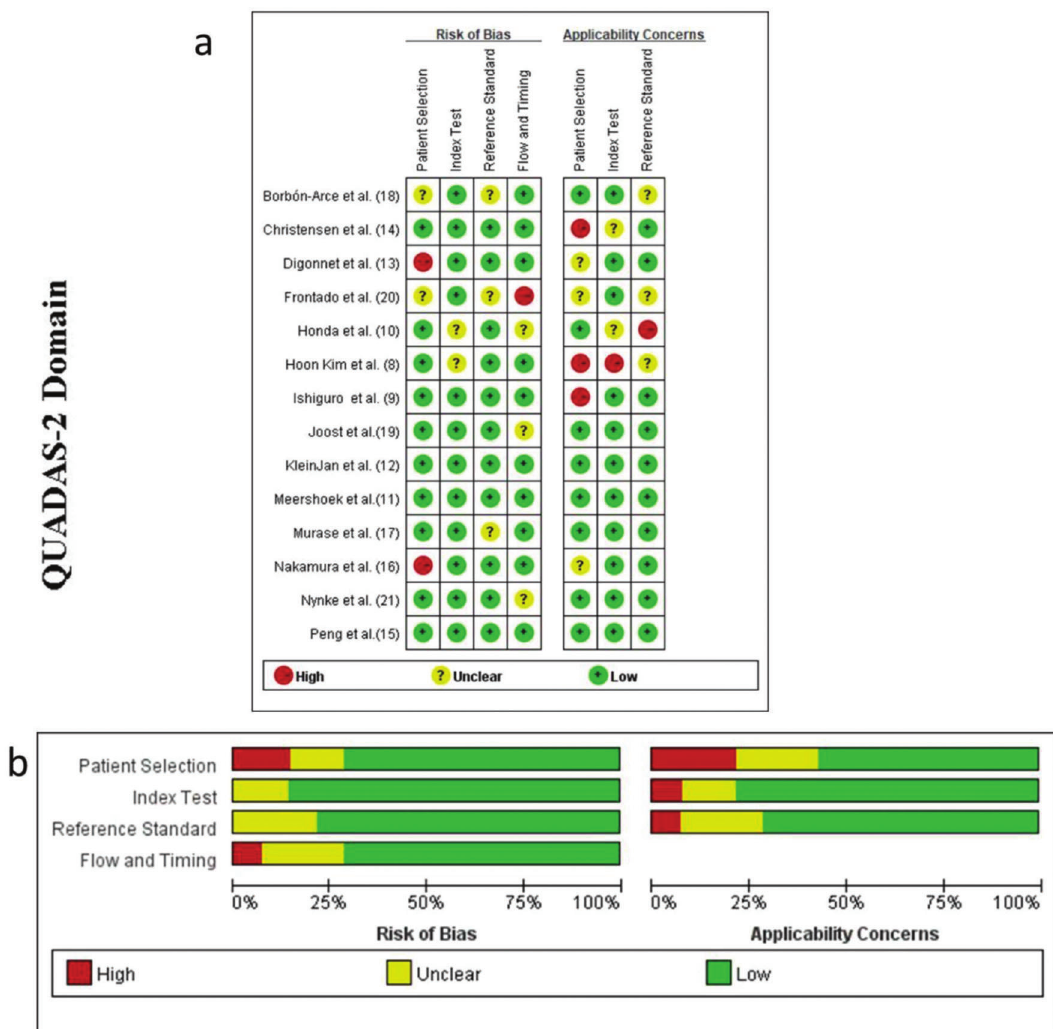
Figure 2 - Methodological evaluation of the included studies according to the QUADAS-2 criteria (a) overall and (b) by study QUADAS, Quality Assessment of Diagnostic Accuracy